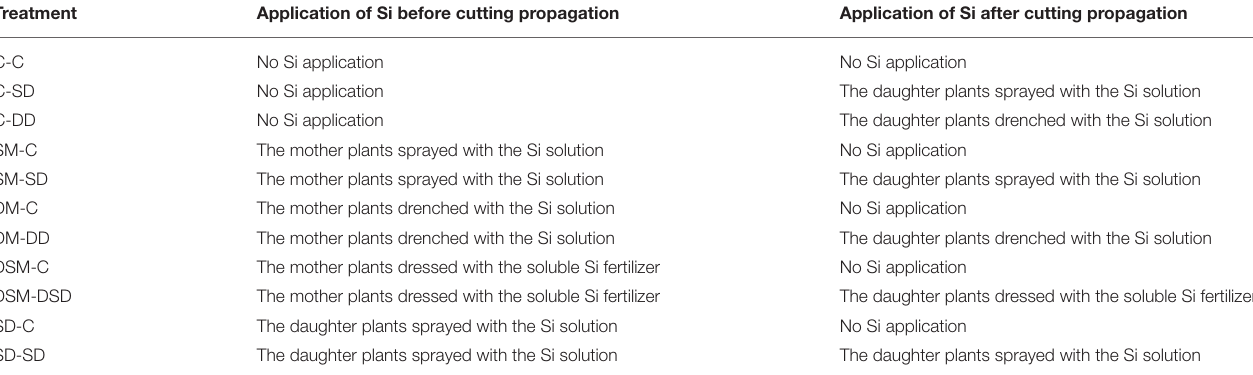
TABLE 1 | Methods of Si application for strawberries.